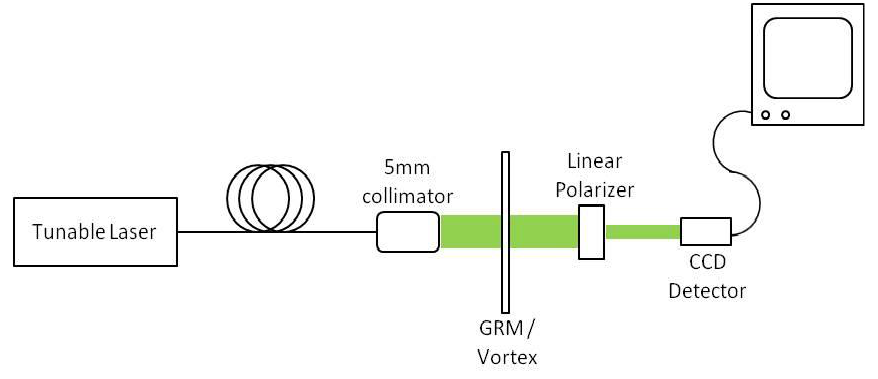
Figure 15. Experimental Setup used to test the azimuthally varying